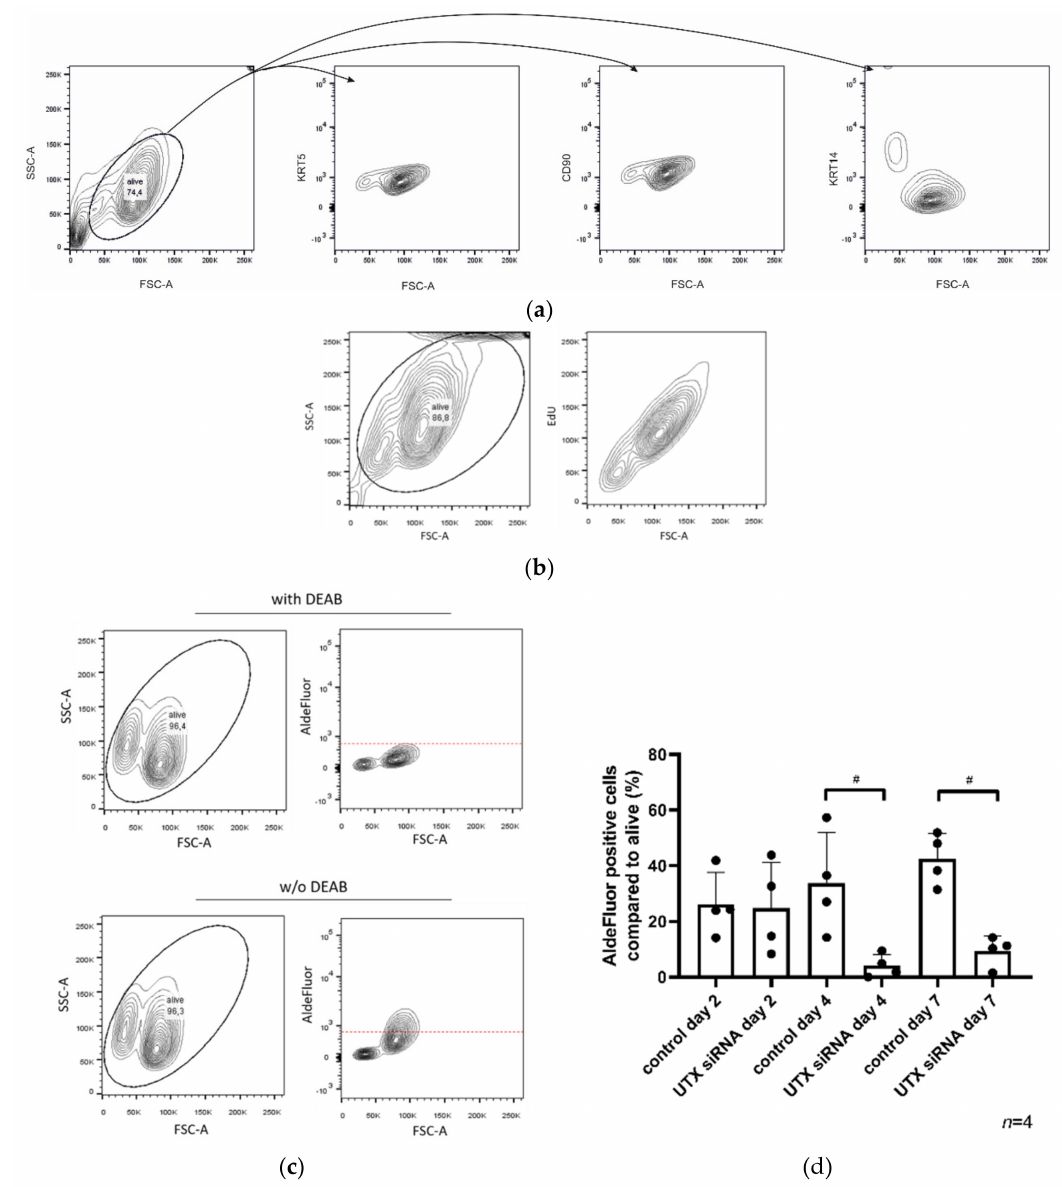
Figure 5. HBLAK contains two cell populations. ( a ) HBLAK cells homogeneously express CD90 and KRT5, but two subpopulations are distinguishable by size and KRT14 staining; namely, FSC-A low / KRT14 high and FSC-A high / KRT14 low . ( b ) The larger KRT14 low cells are more intensely labeled by EdU staining. ( c ) The FSC-A high / KRT14 low population is additionally distinguishable by high AldeFluor-assay activity. In ( a – c ), evaluated cells are circled. ( d ) E ff ect of UTX knockdown using siRNA 01 on the proportion of the AldeFluor pos population. As a negative control, DEAB reagent (inhibitor of the AldeFluor-assay) was used. Significant di ff erences were observed 4 and 7 days after transfection of control siRNA or UTX-siRNA. Number of analyzed independent experiments, n = 4. Statistics were performed with a one-way ANOVA with a post-hoc Tukey HSD test (# p < 0.05). Analysis of the HBLAK cell line by single cell RNA sequencing (scRNA-seq) revealed several cell